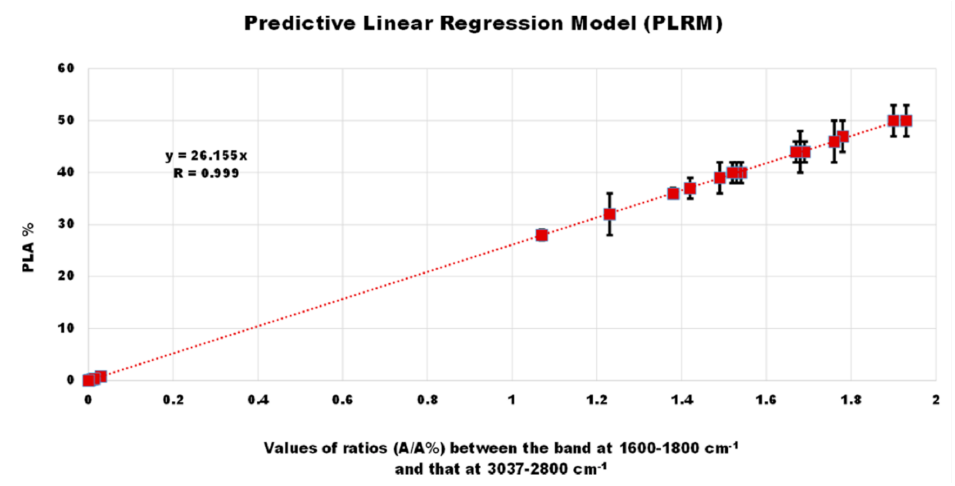
Figure 9. Self-validated predictive linear regression